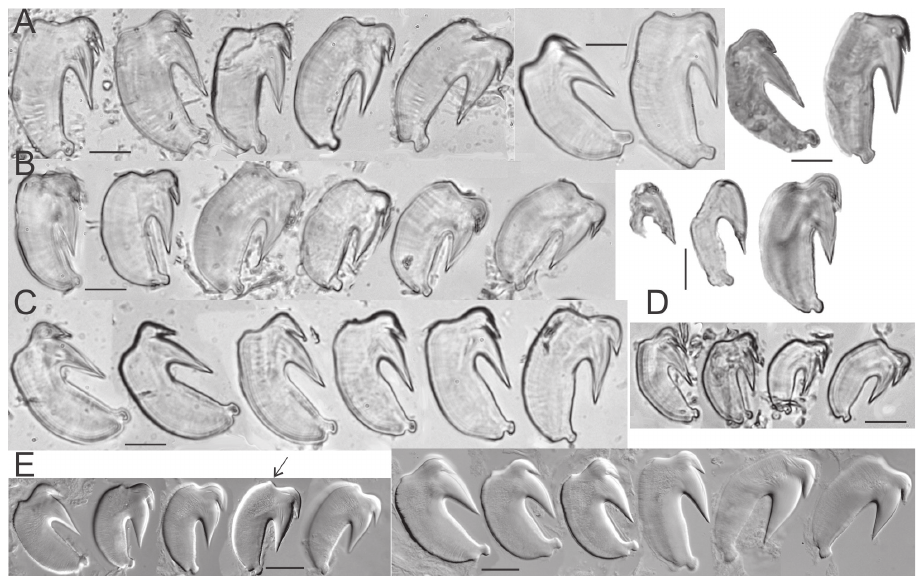
Figure 3. Thelepus cincinnatus and Thelepus antarcticus uncini. A Alaid 30.6 B Alaid 30.8 C, D Alaid 30.13 A–C uncini from U1 D uncini from posterior body E Thelepus antarcticus ZIN IV.1.2, arrow indi- cating hump, which is different from that in T. cincinnatus . Each block from one specimen, all uncini from TU1. Third block of A and second block of B shows stage of development of uncini. Scale bars: 20